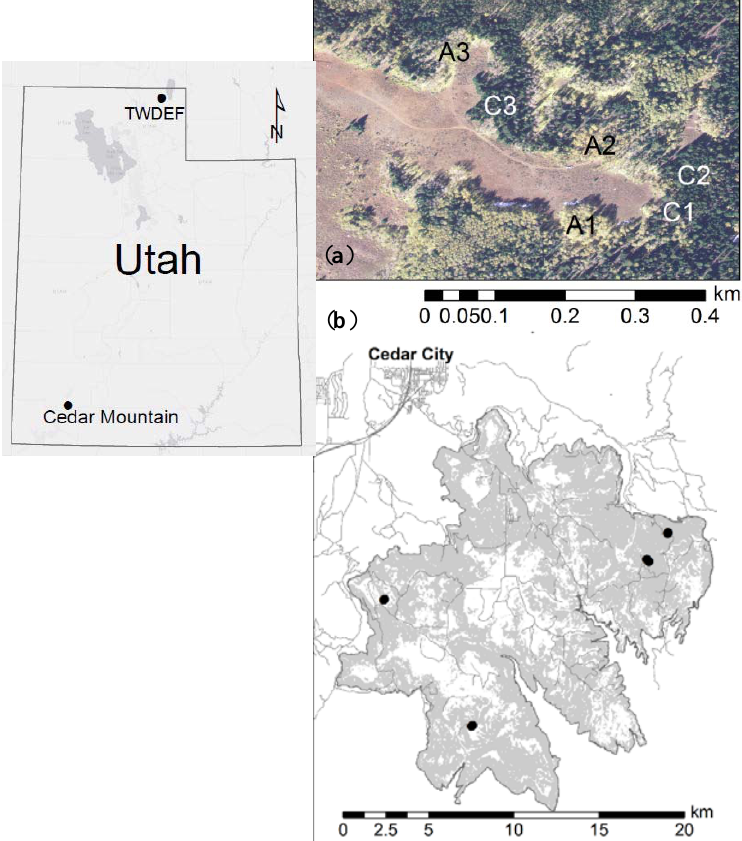
Figure 1. Location of sampling sites: ( a ) T.W. Daniels Experimental Forest (TWDEF) site with six intensive measurement plots; and ( b ) pairs of extensively measured plots at four Cedar Mountain (CM) sites.